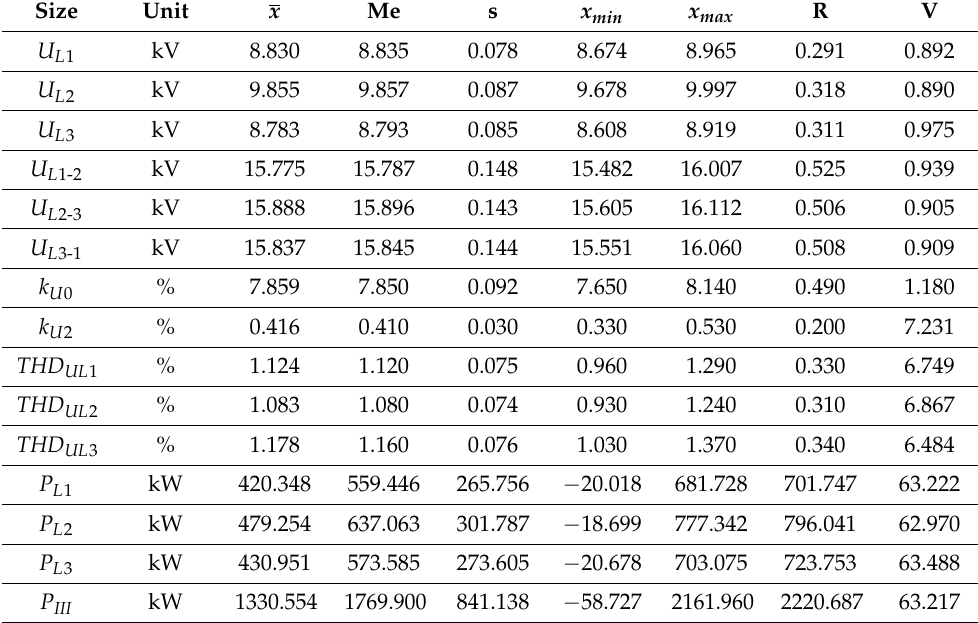
Table 4. Results of statistical analysis of quantities characterising voltage quality at the point of connection of the analysed wind power plant to the power grid.